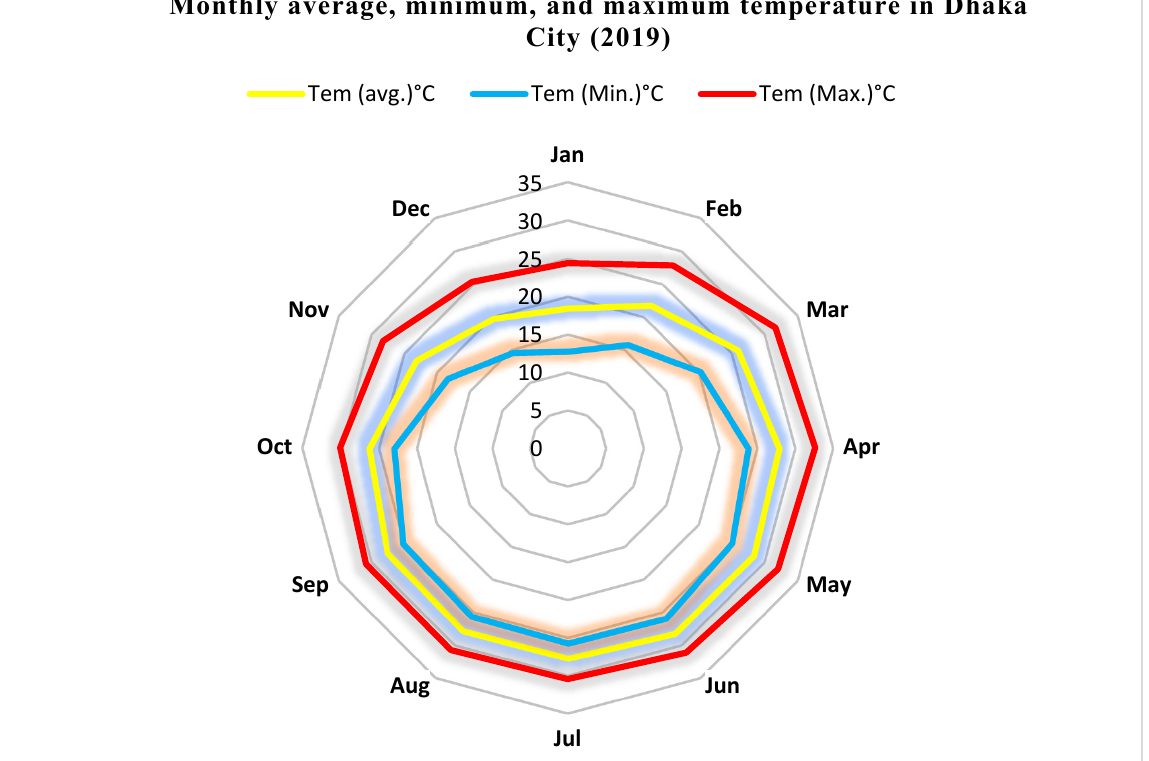
Figure 4. Monthly average, maximum, and minimum temperature in Dhaka City (January to December), 2019.